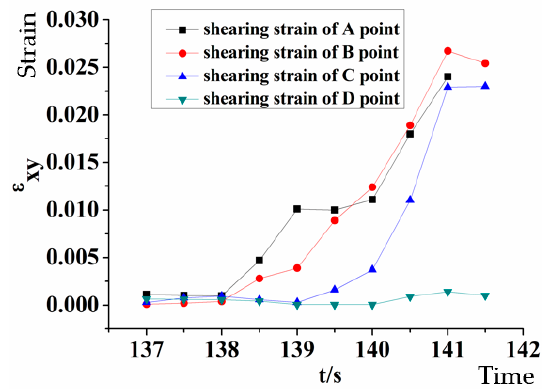
Figure 10. Shear strain–time relationship of sandstone (loading rate = 0.1 MPa/s).